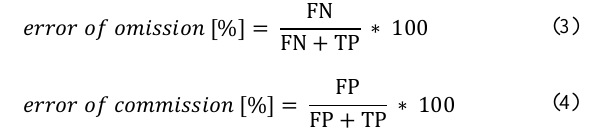
Figure 2. Manually delineated outlines of exactly localizable roads and roofs used for the accuracy assessment overlaid on UAV orthoimages of ( a ) Amtsvenn in Germany and ( b ) Toulouse in France. Outlines in close spatial proximity, such as two parallel outlines of roads, might appear as a thicker line, as they consist of two parallel lines in the reference